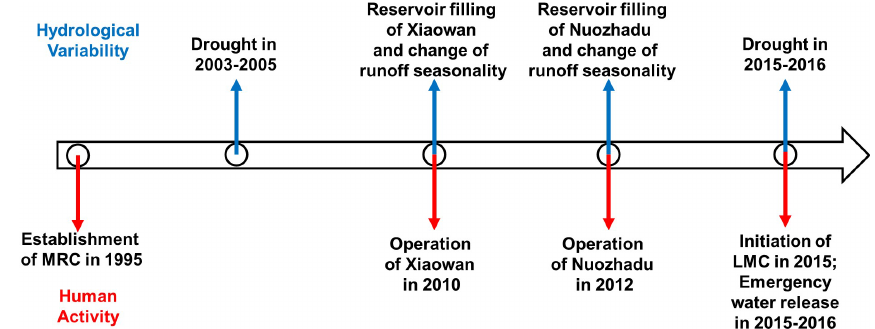
Figure 2. Timeline of hydrological and anthropogenic events in the Lancang–Mekong River basin.